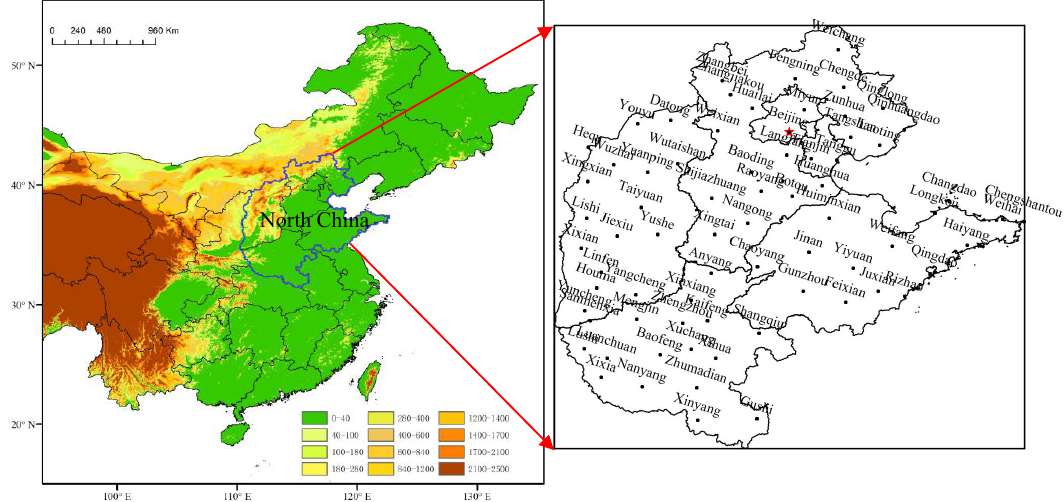
Figure 1. Map of study area (North China) is surrounded by blue solid line (shading indicates the topography; unit: m; dots are 72 stations in North